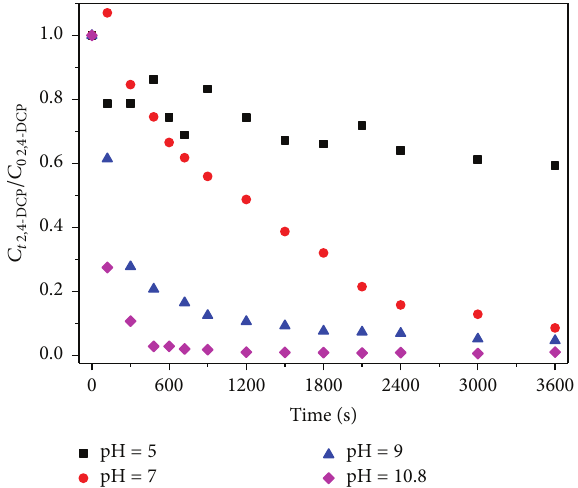
Figure 4: The dependence of the reaction rate photosensitized oxidation of the initial substrate concentration of 2,4-DCP using RB as a photosensitizer ( 𝐶 0 sens . = 2 × 10 −5 M, air bubbling, and xenon lamp irradiation).